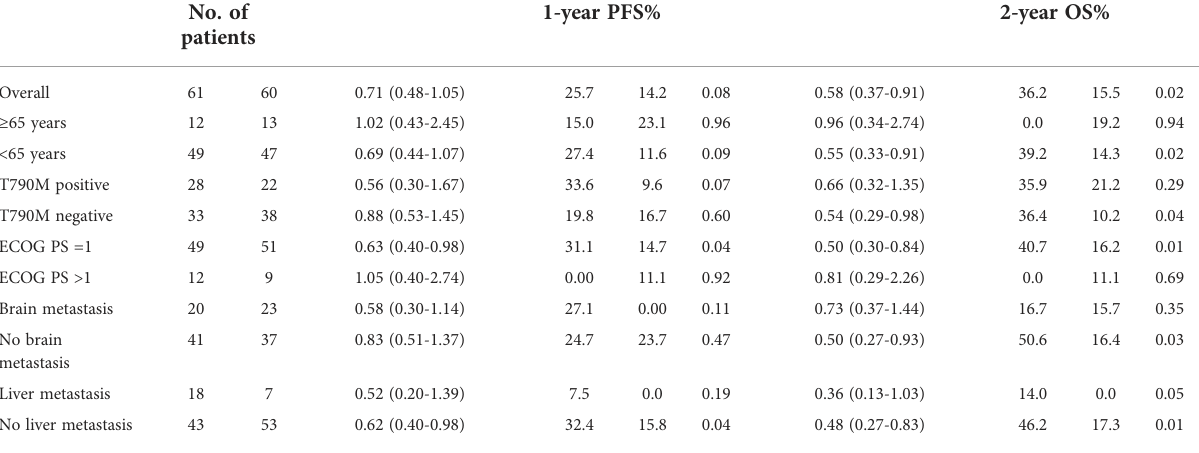
TABLE 3 Subgroup analysis of the outcome of patients receiving ICI in combination with chemotherapy and chemotherapy alone.